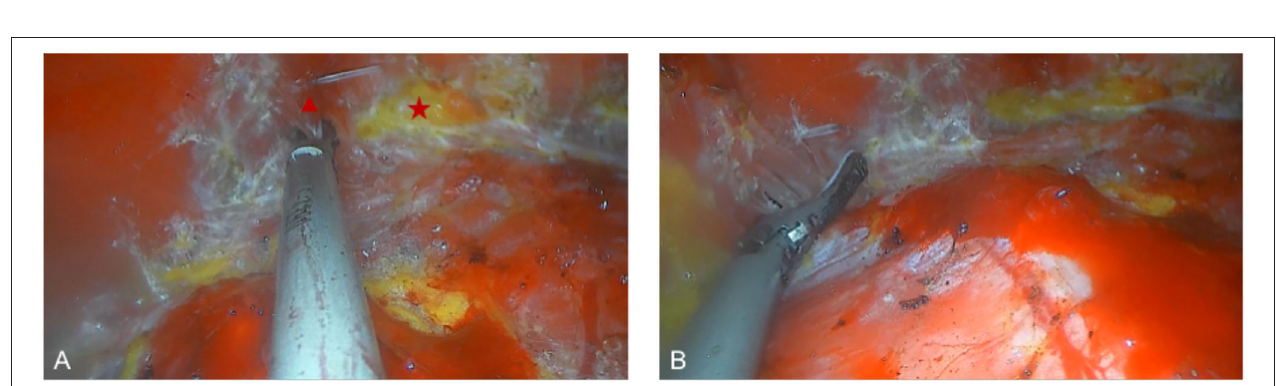
FIGURE 3 | The medial and upper pockets were dissected during endoscopic transaxillary breast augmentation. (A) Arrows indicate multiple intercostal perforators of internal thoracic artery perforating vessels can be clearly observed in the second and fourth intercostal spaces. (B) Arrow indicates a deep blood vessel from the pectoralis minor to the pectoralis major near the second rib of the midclavicular line.